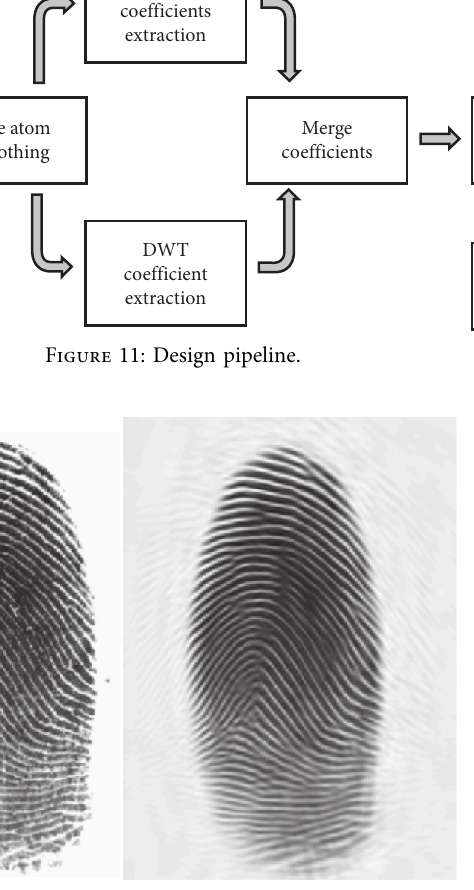
Figure 12: Input image (left) and smoothened image using wave atom transform